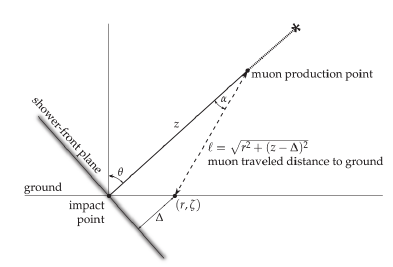
Figure 1. Schematic sketch of the geometry used to calculate the point where a muon was produced in the atmosphere,